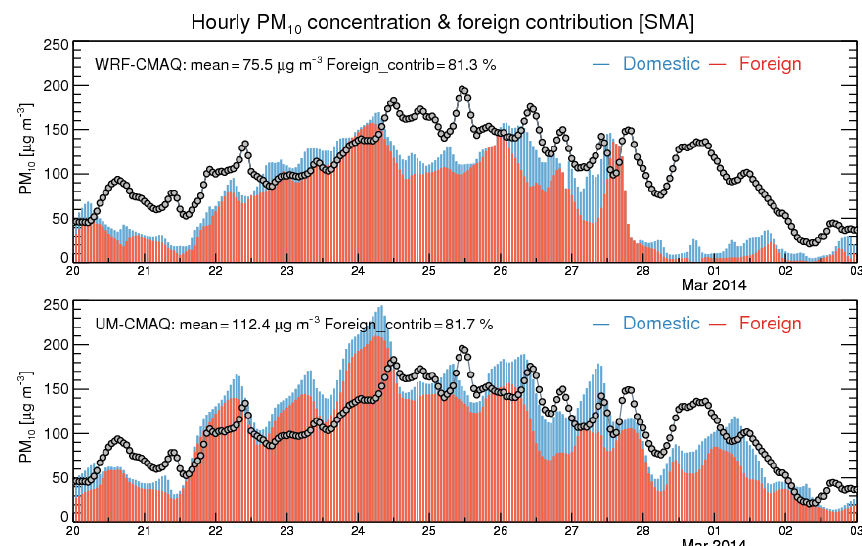
Figure 8. Time series of surface PM 10 concentration over the SMA from observations and models during the period from 20 February to 2 March 2014. Contributions from domestic and foreign emissions are shaded with blue and red, respectively. Table 3. Summary of NO x , SO 2 , NH 3 , and PM emissions for INTEX-B 2006, MICS-Asia 2010, and CAPSS (2007 and 2010) emissions inventories. China South Korea SMA NO x emissions; unit: tons per year